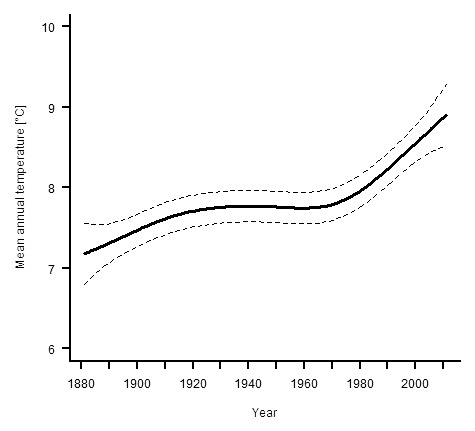
Mean annual temperature in southern Germany between 1881 and 2011.Solid line – regression spline fit from the GAM; dashed lines – 95% confidence intervals.